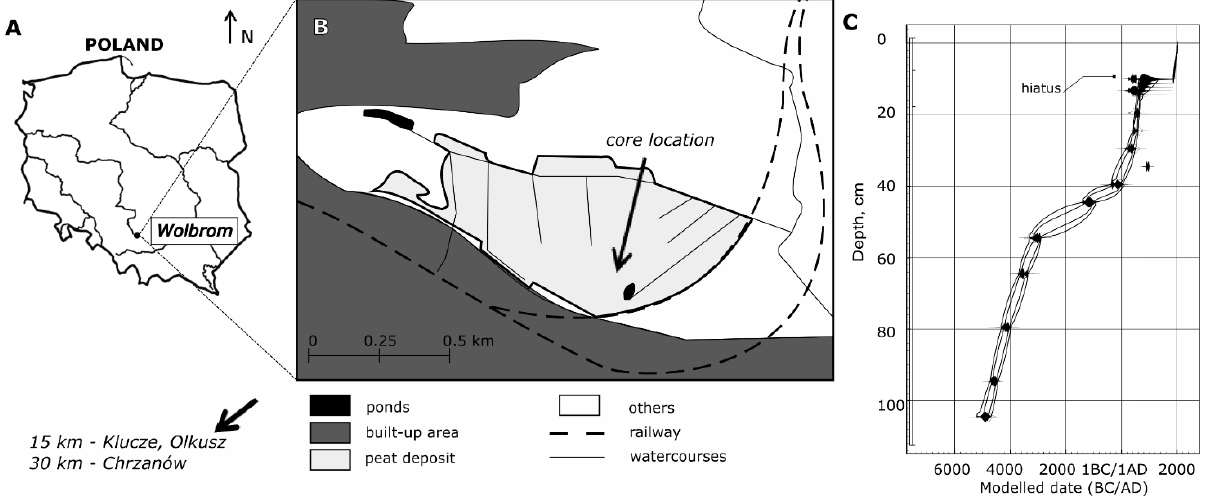
Figure 1. Maps showing the locations of the site (A) and Peat Core W3 (B). The direction and approximate distances to the Klucze, Olkusz and Chrzanów mineral ore mines are indicated. The age-depth model for Peat Core W3 (C) was previously reported by Pawełczyk et al .